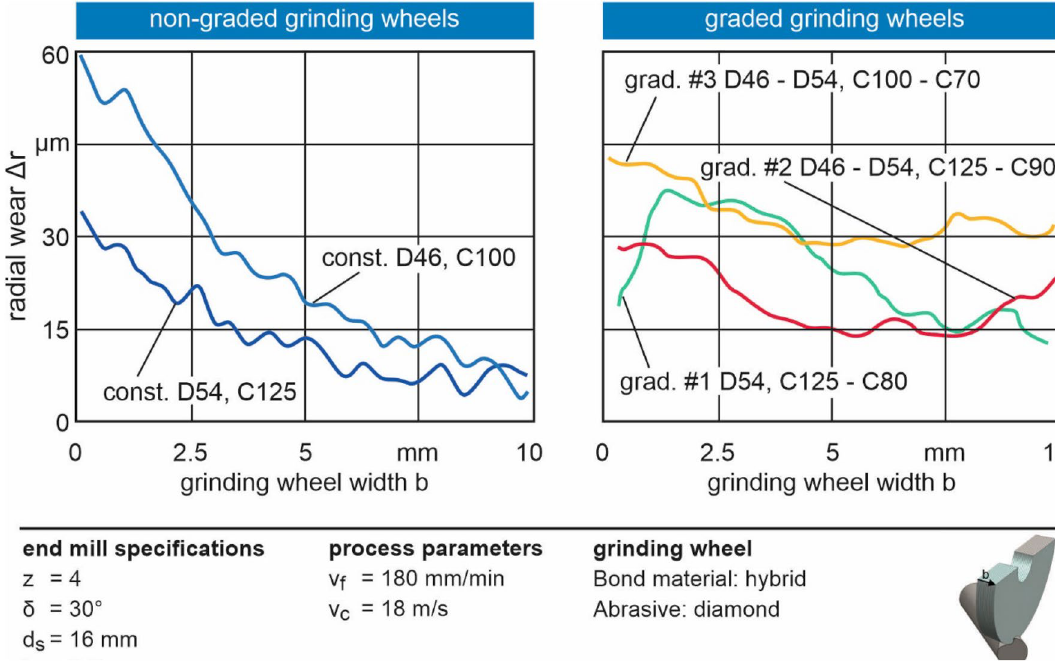
Fig. 6 Radial wear over the grinding wheel